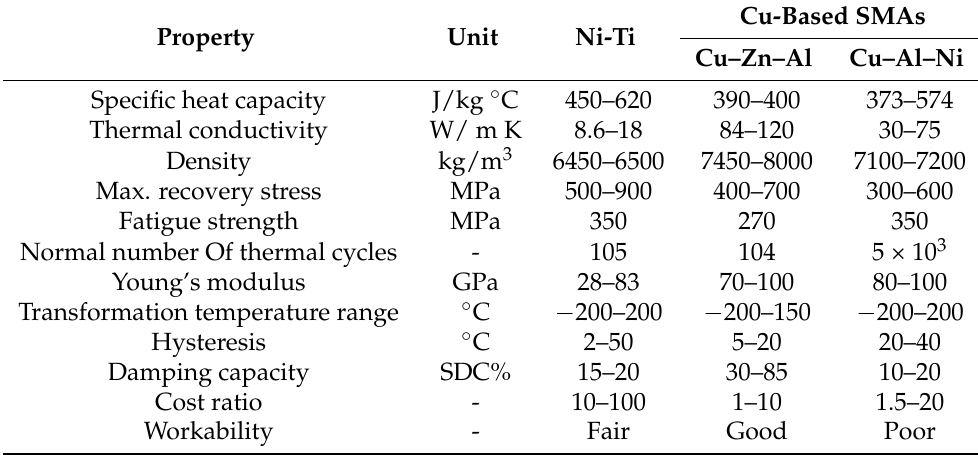
Table 2. Comparison of several properties between main Cu-based and Ni-Ti SMAs.